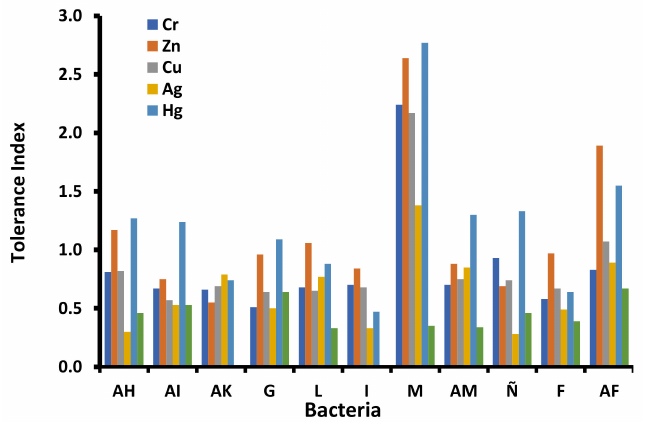
Figure 2. Tolerance index of selected bacteria to heavy metal